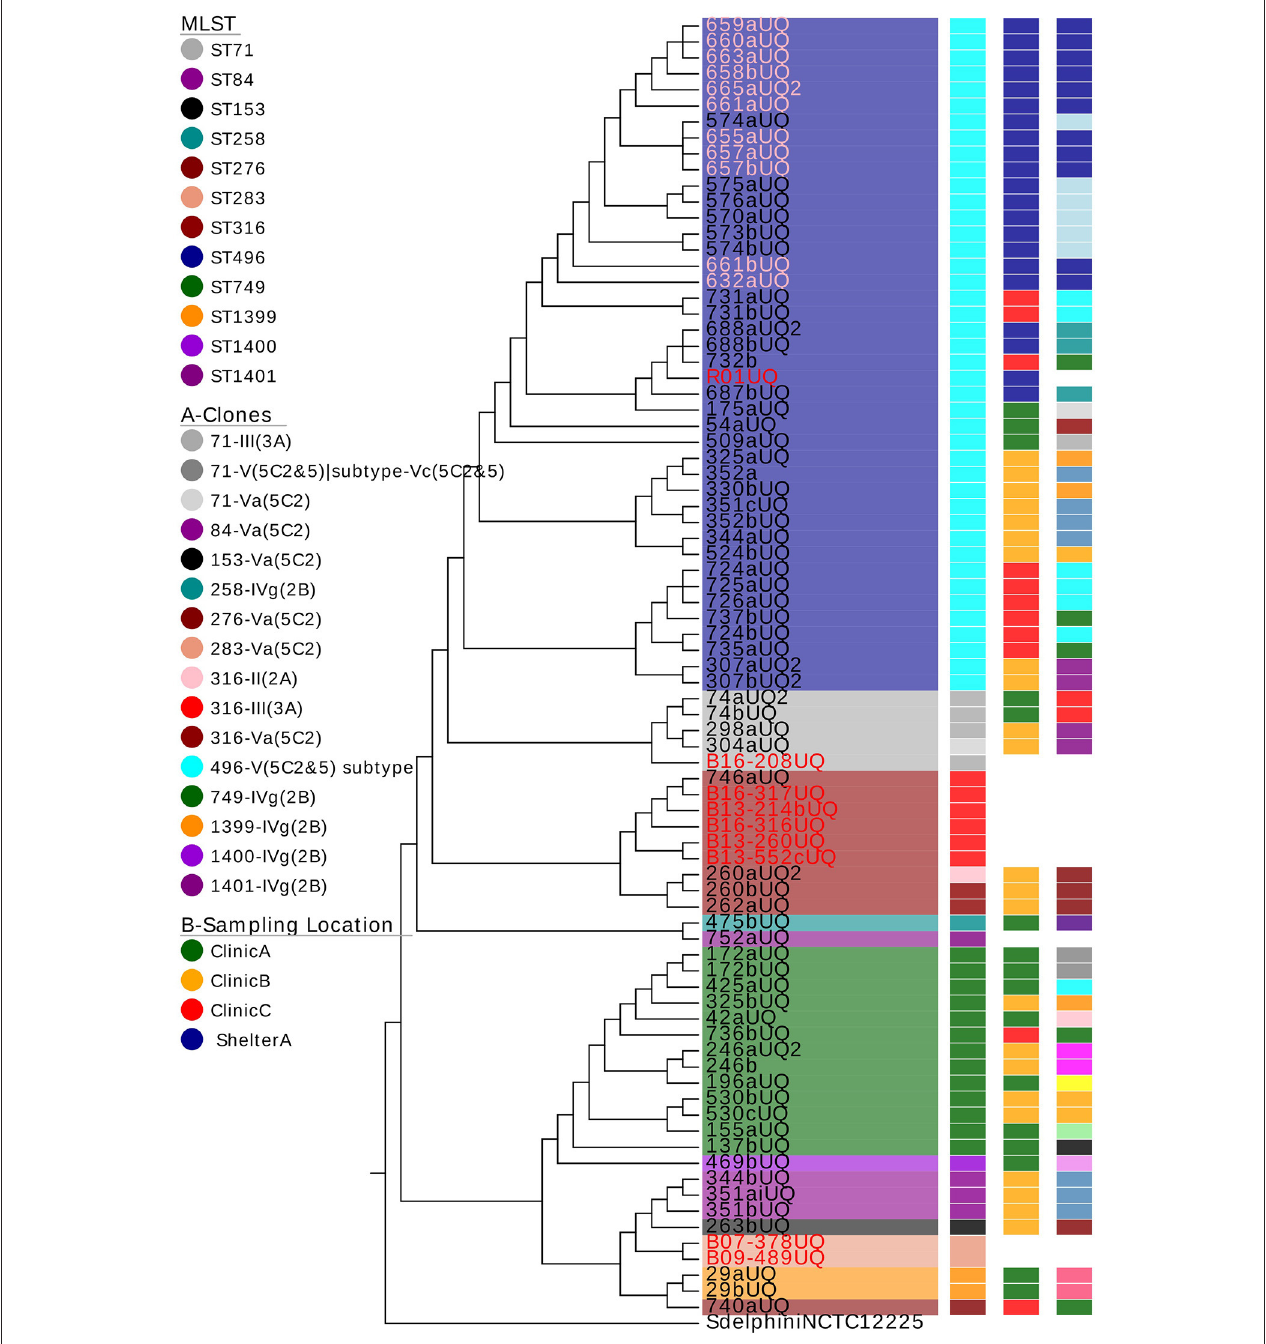
FIGURE 1 | The phylogenetic tree of all methicillin-resistant Staphylococcus pseudintermedius (MRSP) isolates and associated metadata. The colors behind the isolate names represent the multilocus sequence types (MLST). The isolates highlighted in pink are MRSP isolated from cats. The rest of the isolates are isolated from dogs. The isolates highlighted in red are clinical isolates. The column labeled A = MRSP clones with the same MLST and SCC mec types; B = the sampling location, C = the date of sampling. The colors used in column C indicate a different sampling date (i.e., same day = same color). Samples 425 and 172 were isolated from the same